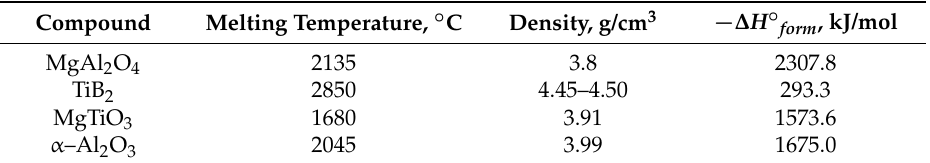
Table 1. Physicochemical properties of